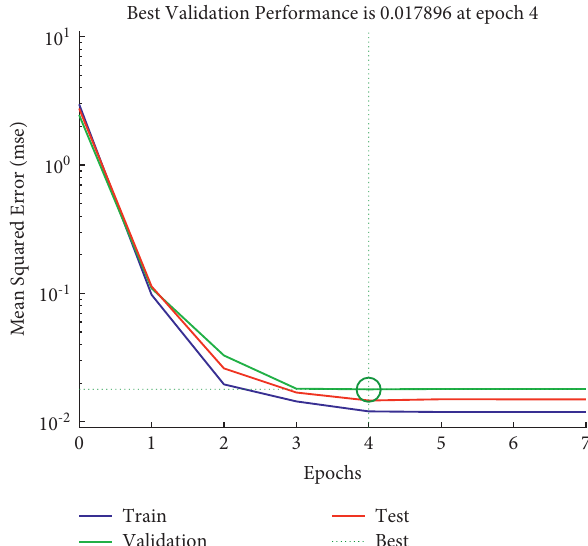
Figure 5: Iteration process for determining the best ANN model.